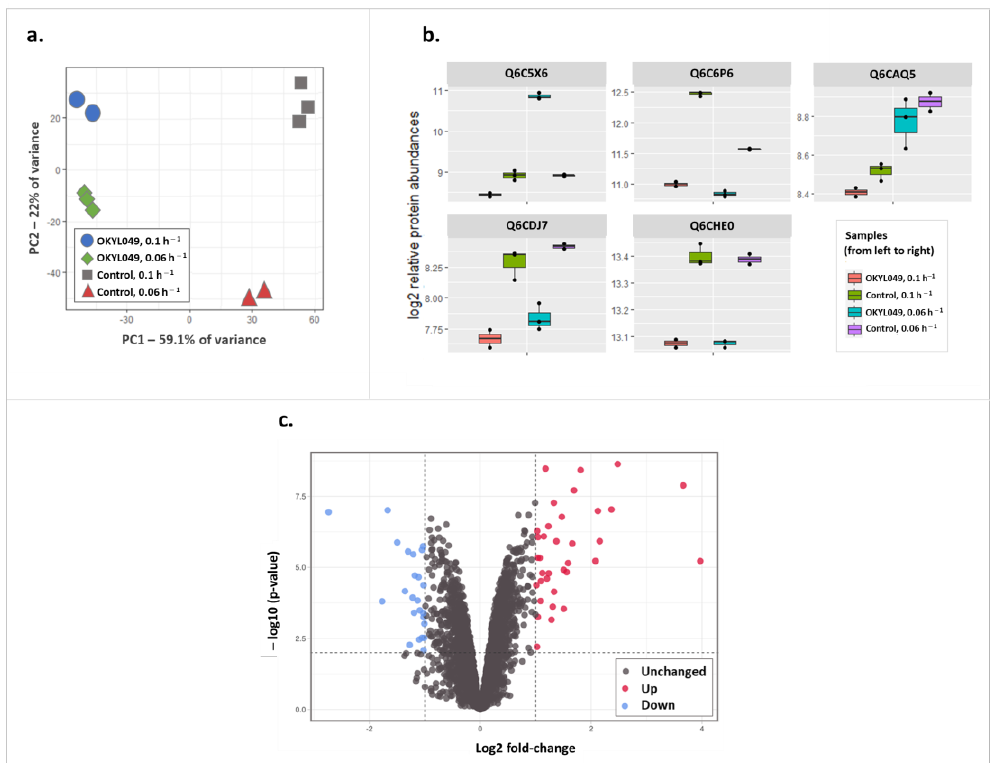
Figure 2. Differential expression analysis on the proteomic data. ( a ) PCA (principal component analysis) plot highlighting similarities between individual replicates and clear separation between test groups; ( b ) box plots of examples of protein expression-change behaviors that the current study is or is not interested in (see text); ( c ) volcano plot highlighting differentially expressed proteins in OKYL049 with lower dilution rate compared to the control strain. The dots in red and blue indicate proteins with significantly altered levels (|log2 FC| > 1, p -value < 0.01).